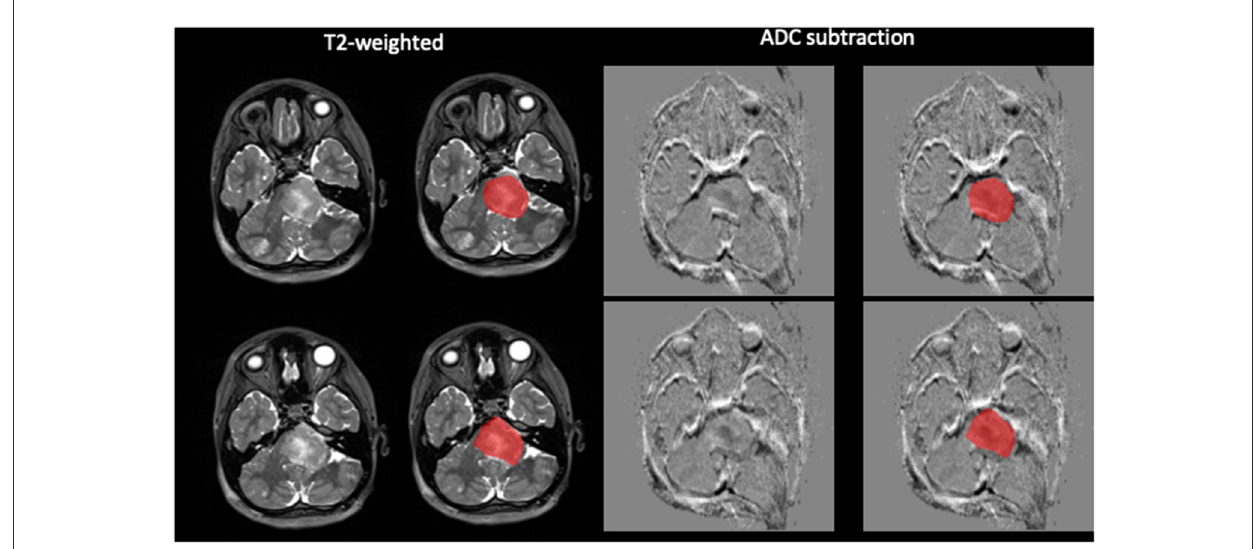
FIGURE1 Demonstration of semi-automated tumor segmentation. Tumor segmented on T2W image using normal appearing white matter signal intensity as threshold. ADC subtraction image with the segmentation superimposed.